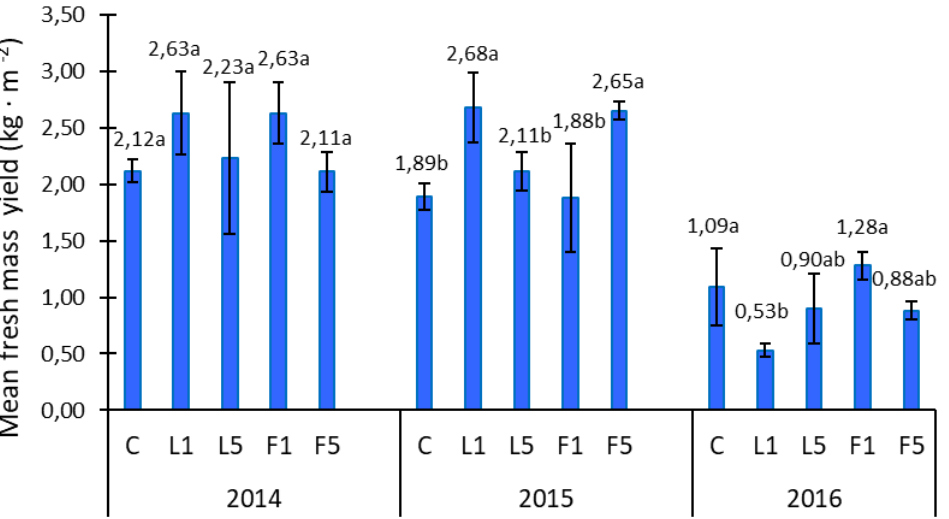
Figure 4. Fresh mass yield alfalfa. C—control; L1—He–Ne laser, exposition time 1 min;